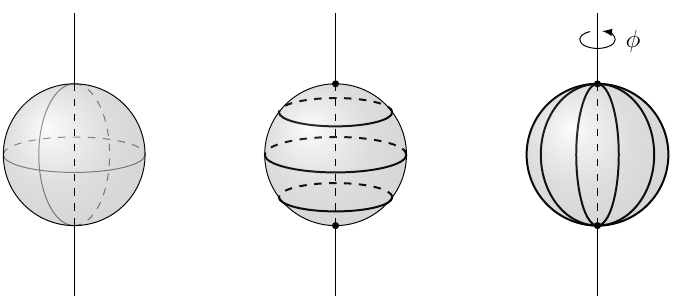
Figure 1 . The diagrams that dominate in the calculation of entanglement entropy are sphere diagrams such as the one depicted on the left. Sliced transverse to the entangling surface, as in the middle (cid:12)gure, this diagram describes a closed string emitted from a point on the entangling surface and then reabsorbed. Sliced in angular time (cid:30) , the sphere diagram is a one loop open string diagram with the endpoints (cid:12)xed on the entangling surface as depicted on the right. The entanglement entropy of the region V in state is de(cid:12)ned as the von Neumann j i entropy of the reduced density